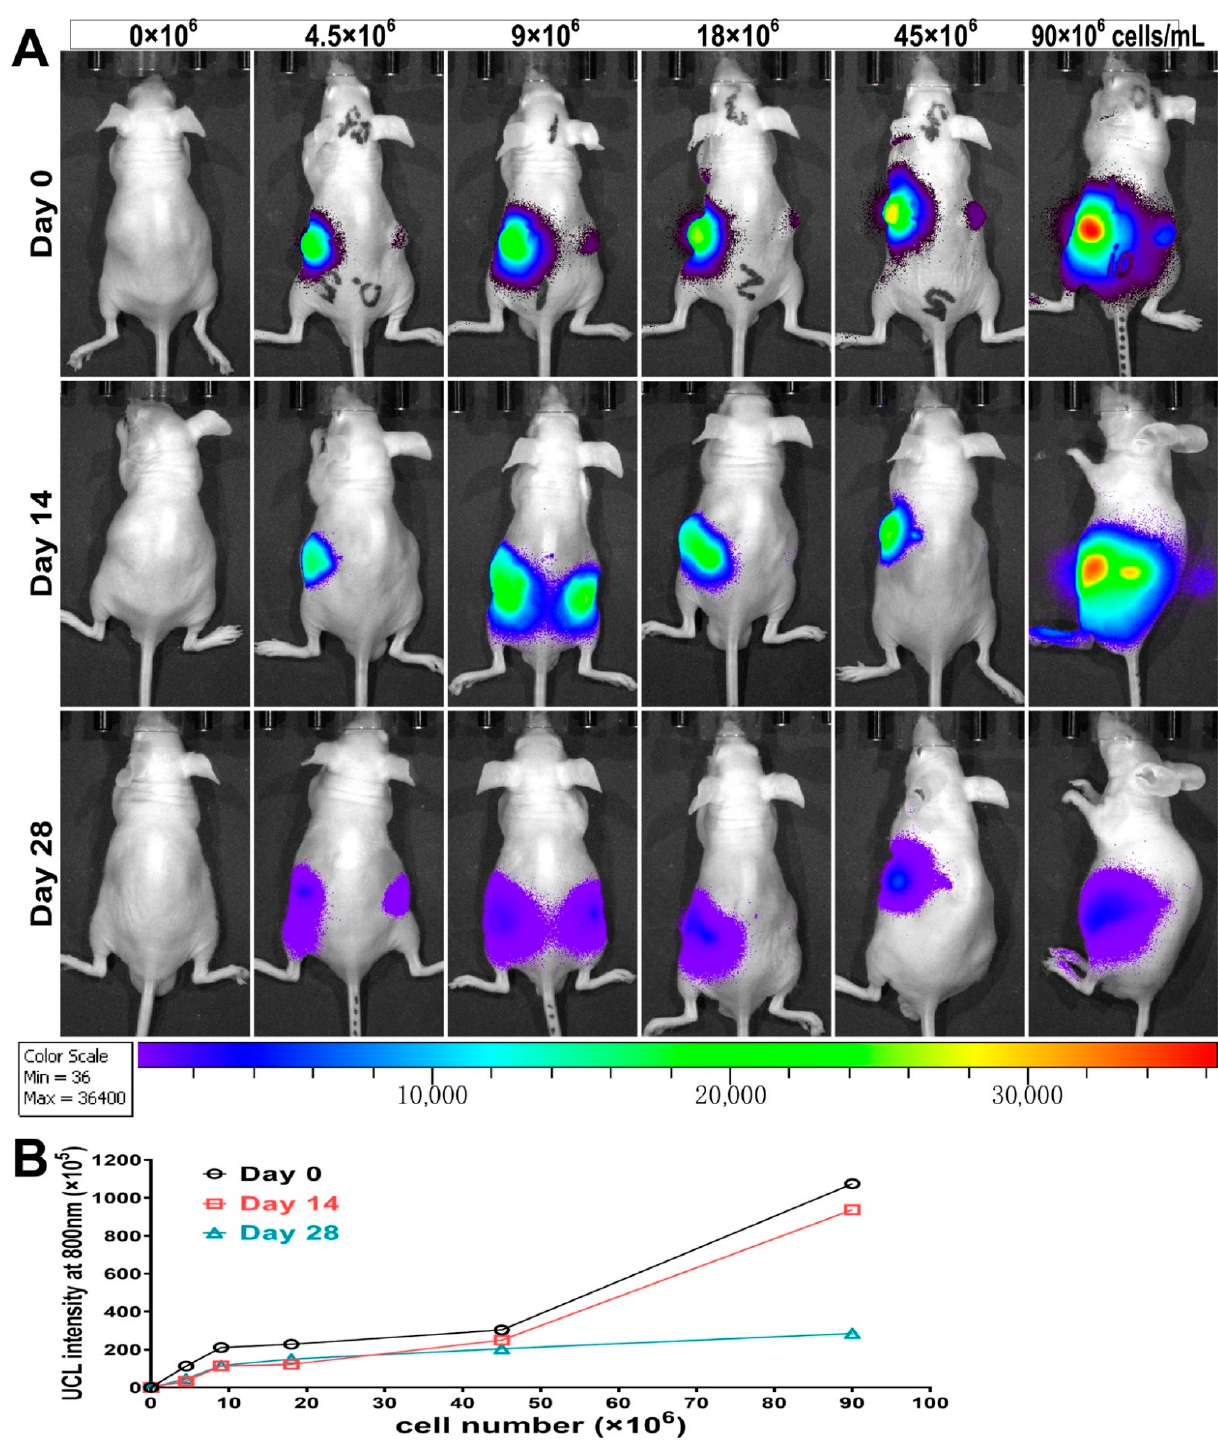
Figure 11. Long-term tracking and quantification of CSPCs engrafted using UCL. ( A ) UCL images of nude rats subcuta- neously implanted with hydrogel constructs containing UCNP@SiO 2 -TS-labeled CSPCs of increasing numbers (4.5–90 × 10 6 cells/mL) taken on days 0, 14, and 28 post-implantation (UCL emission collected at 800 nm in pseudo-color). ( B ) Plots of quantified UCL signal intensity versus the tracked cell numbers.